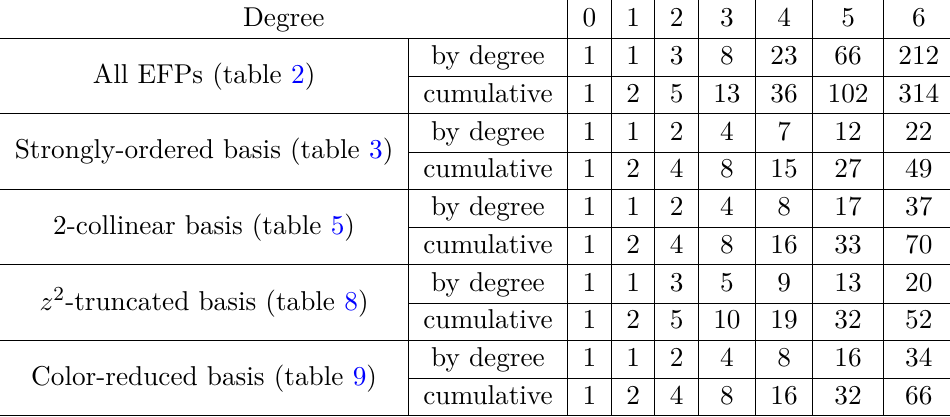
Table 1. The number of all EFPs of/up to degree d , as well as the number of basis elements needed in the strongly ordered, 2-collinear, z 2 -truncated, and color-reduced (1-collinear) expansion.